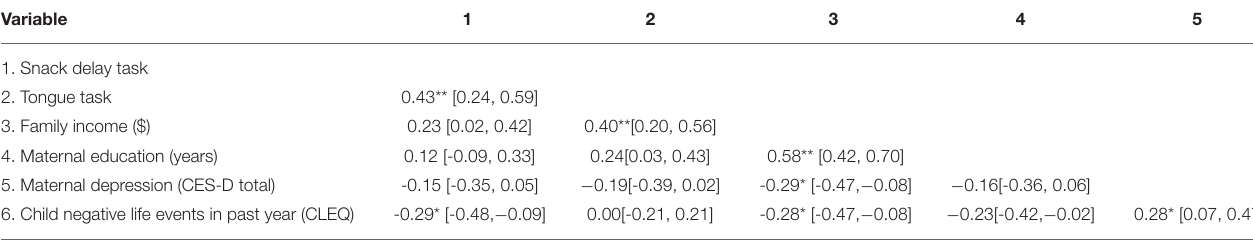
TABLE 4 | Correlations between measures of delay of gratification and family environment.